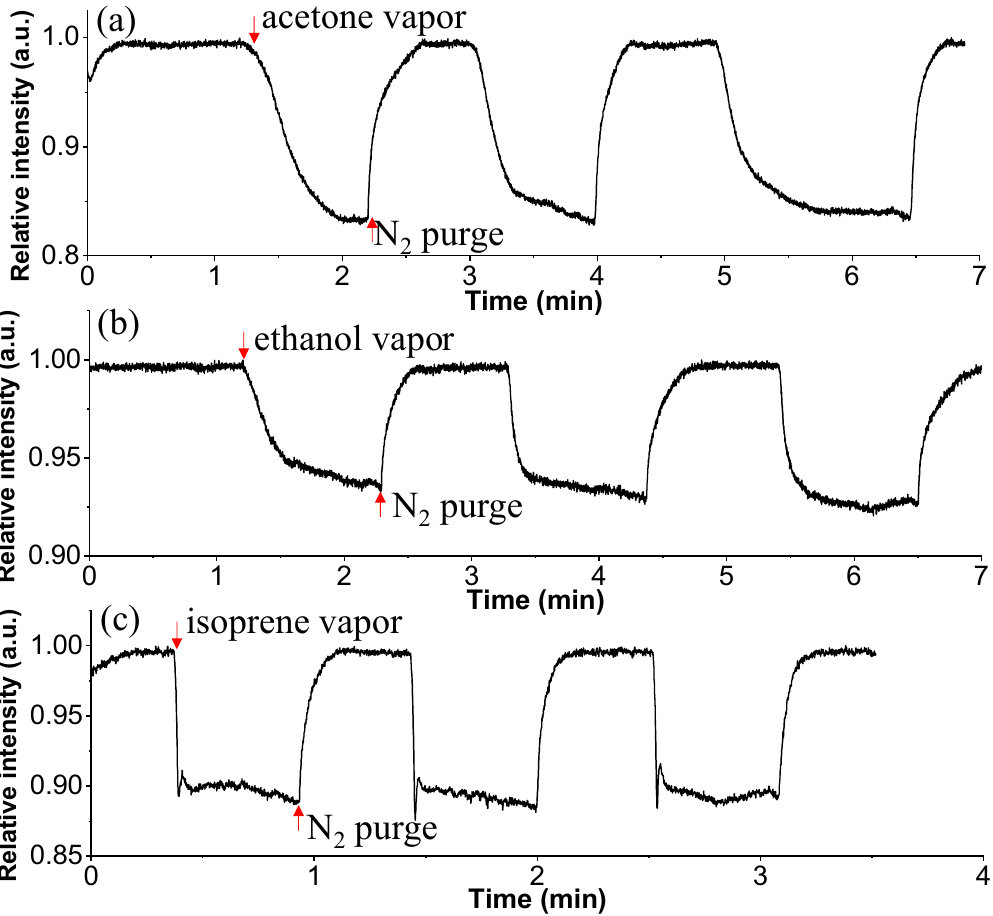
Figure 7. Real-time mid-IR monitoring of pulsed VOCs using SiN waveguides of width = 10 µm and thickness = 1 µm: ( a ) acetone at λ = 3.375 µm, ( b ) ethanol at λ = 3.375 µm, and ( c ) isoprene at λ = 3.400